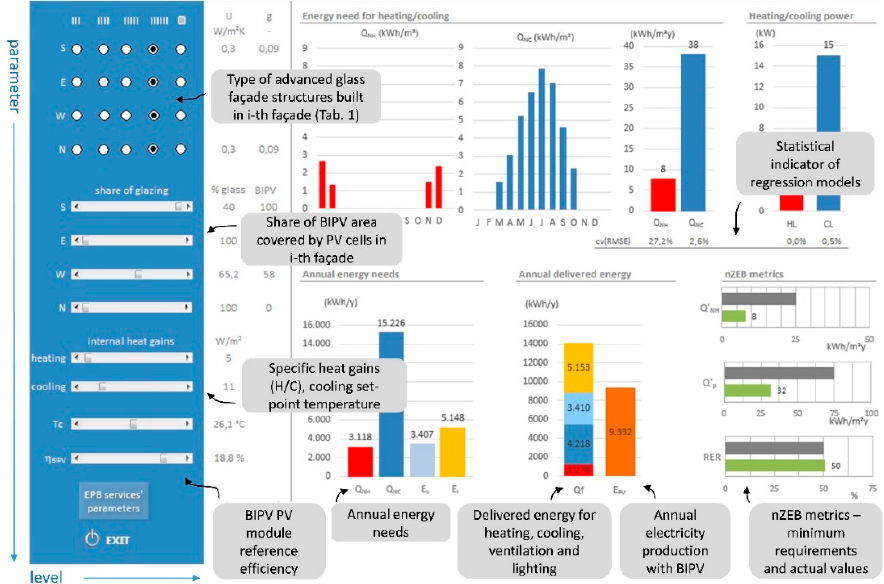
Figure 6. Evaluation GUI with parameter input fields and energy efficiency indicators and nZEB metrics of an analyzed building.